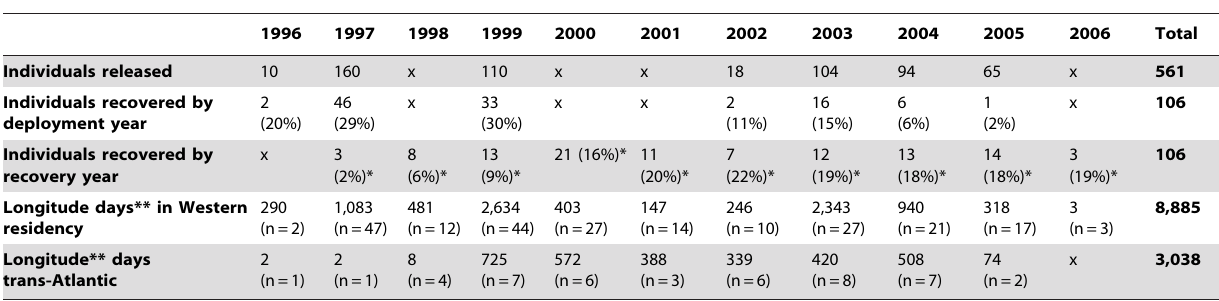
Table 1. Deployment, recovery and position